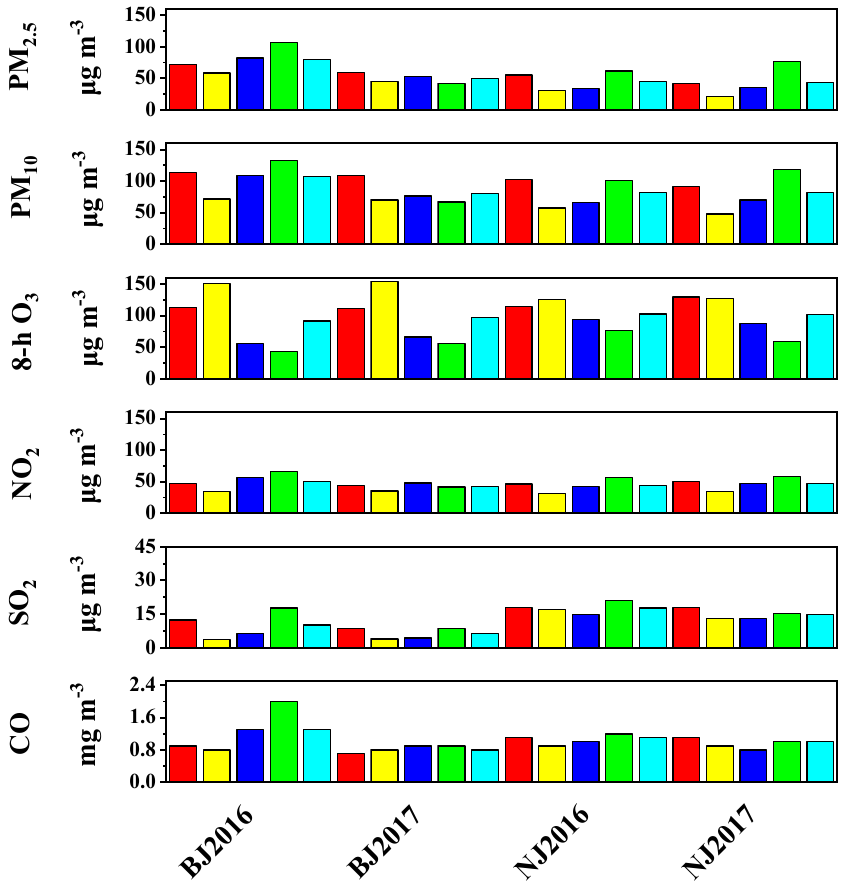
Figure 2. Seasonal and annual average concentrations of six criteria air pollutants in different cities and years. Red, yellow, dark blue, green, and light blue represent spring, summer, fall, winter, and annual values, respectively.